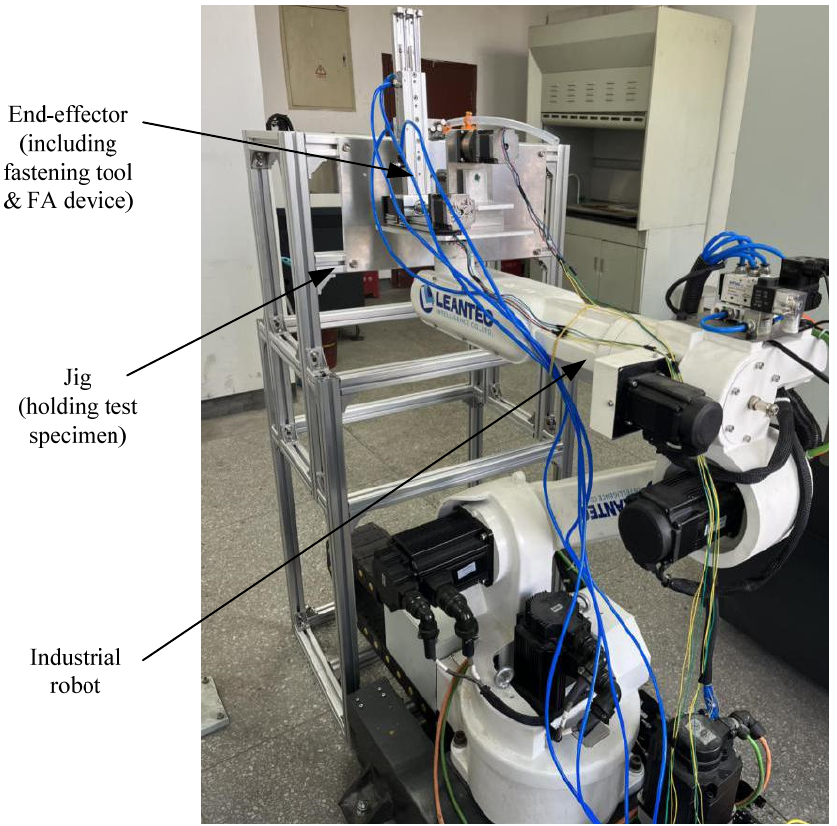
Figure 11. Experimental platform for hi-lok nut automated installation.